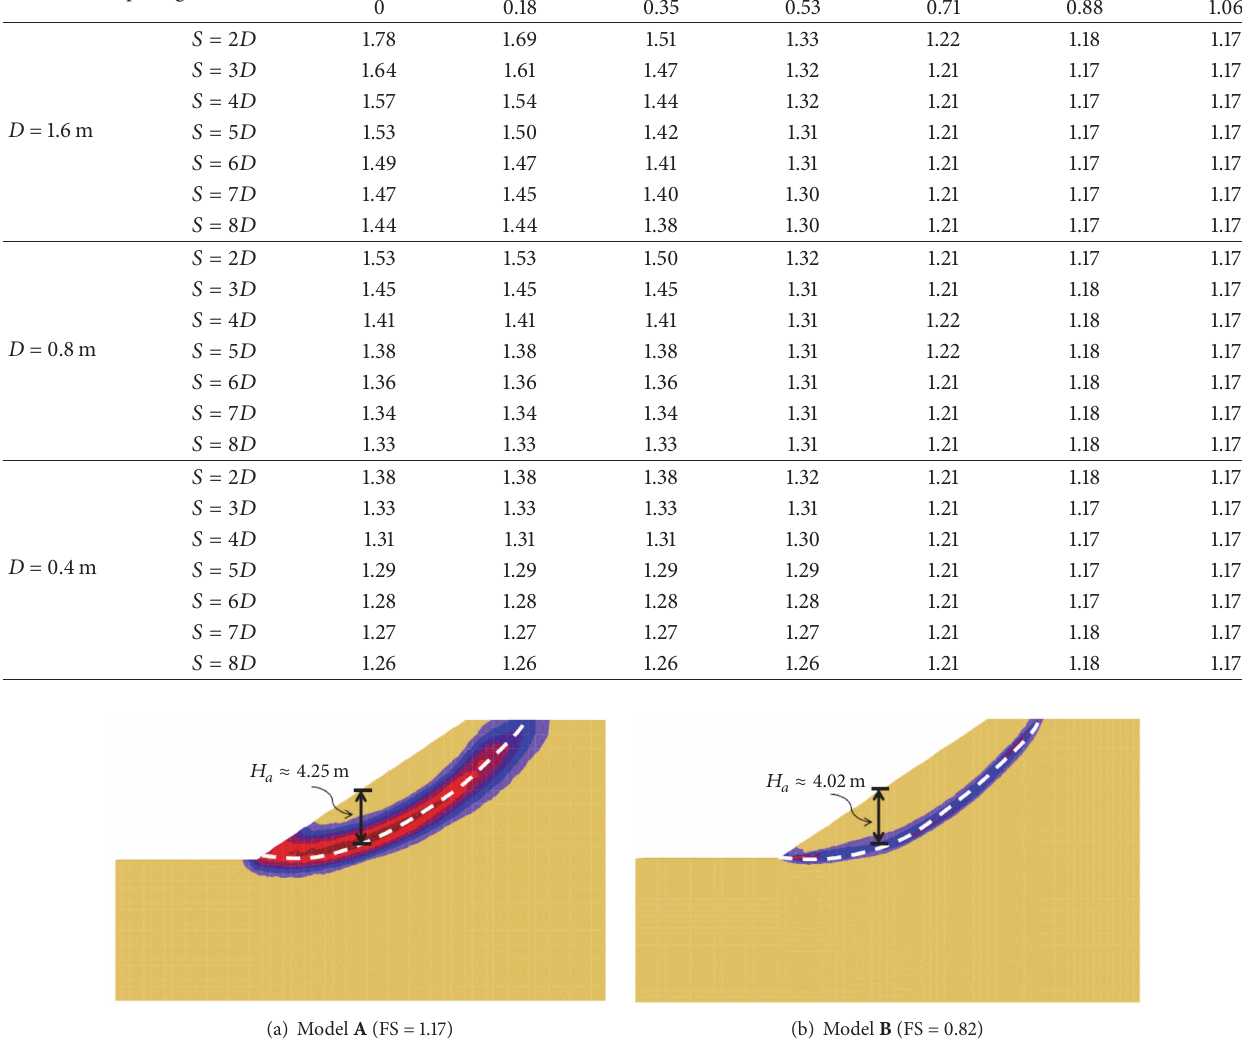
Figure 8: Critical slip surface of unreinforced slopes for Models A and B